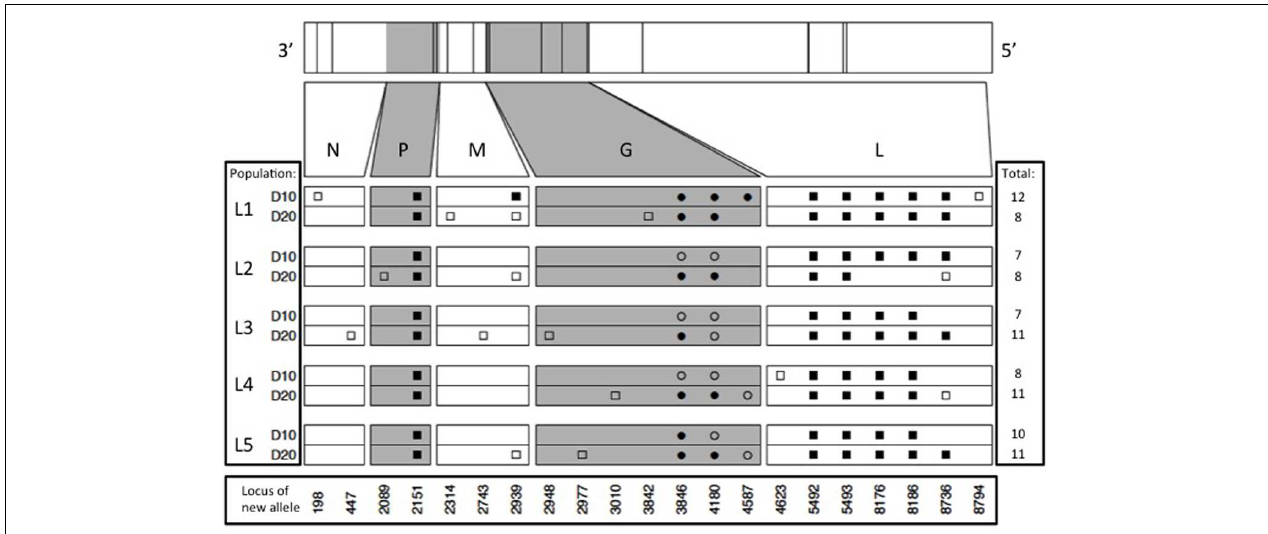
FIGURE 2 | Locations of new mutations relative to the ancestral sequence in the evolved VSV populations, at days 10 and 20 of experimental evolution. Ticks on bars across top indicate physical locations of mutations in the genome. Viral nucleoprotein (N), phosphoprotein (P), matrix protein (M), glycoprotein (G), and large polymerase protein (L) genes are indicated on both scaled and unscaled bars. Within the 10 lower bars, each symbol represents a new nucleotide. Genome location is shown at bottom. Populations sharing symbols in the same locus share the new allele. Squares and circles represent synonymous and non-synonymous changes, respectively, and filled and open symbols represent fixed and polymorphic changes,